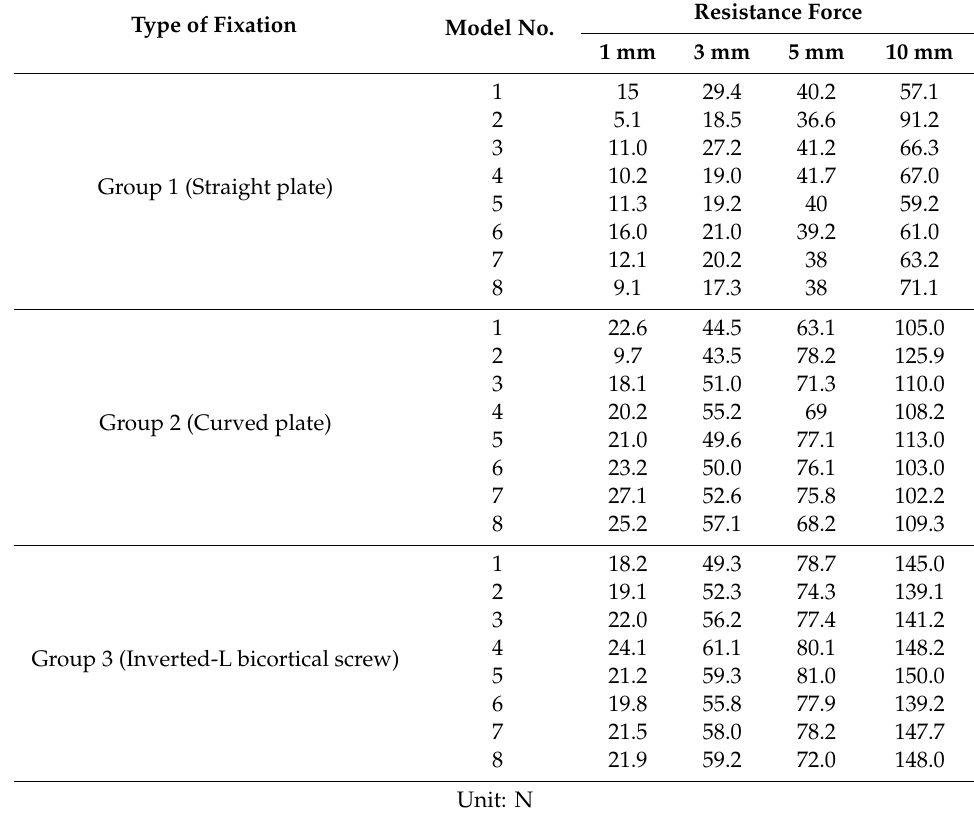
Table 1. Resistance force (N) at the three displacements sites during raw experimental measurement.